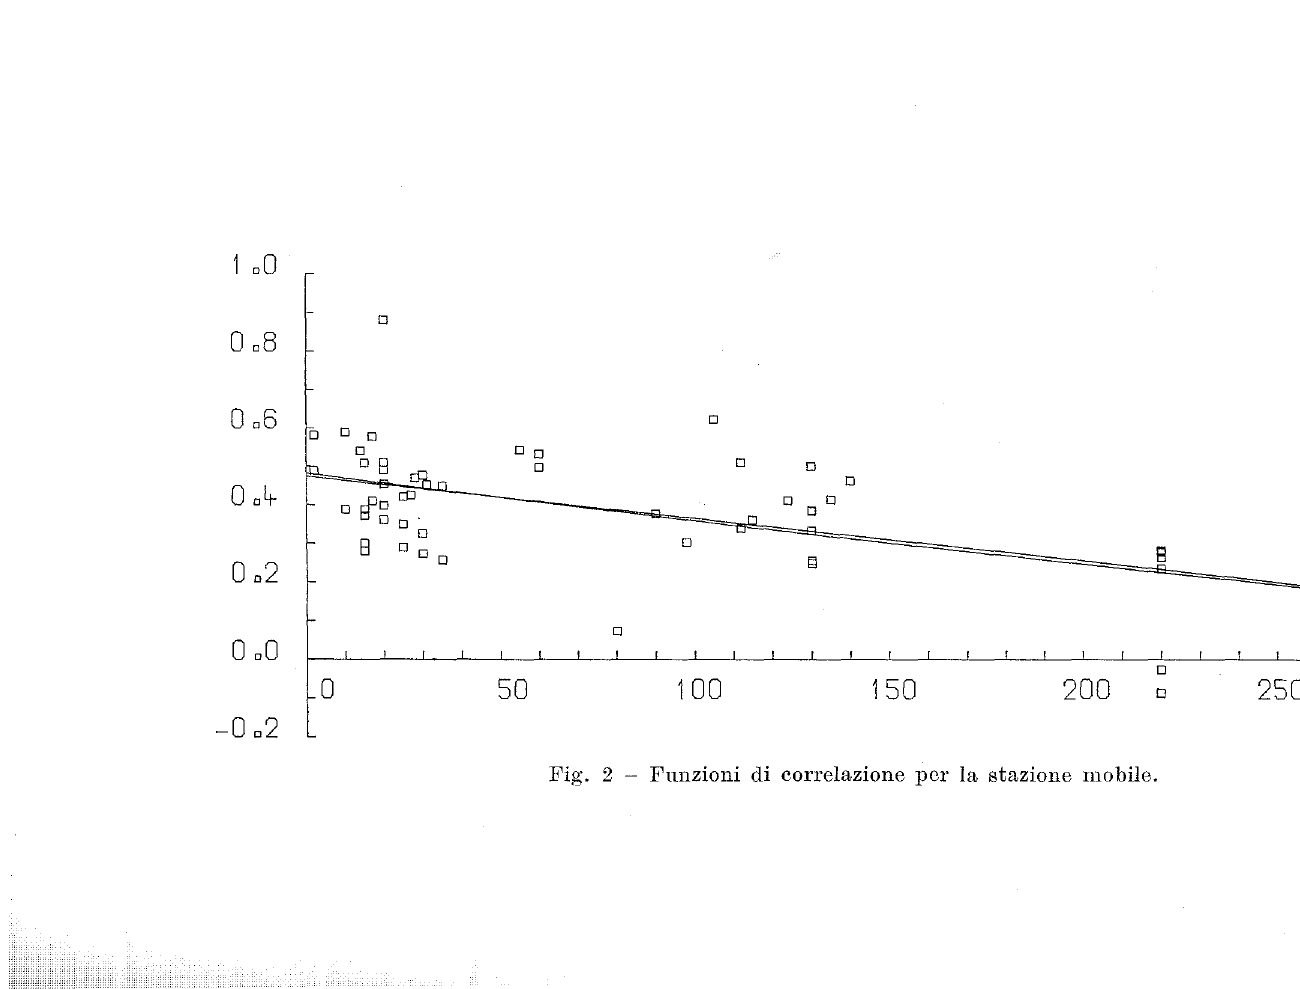
Fig. 2 - Funzioni di correlazione pcr la stazione